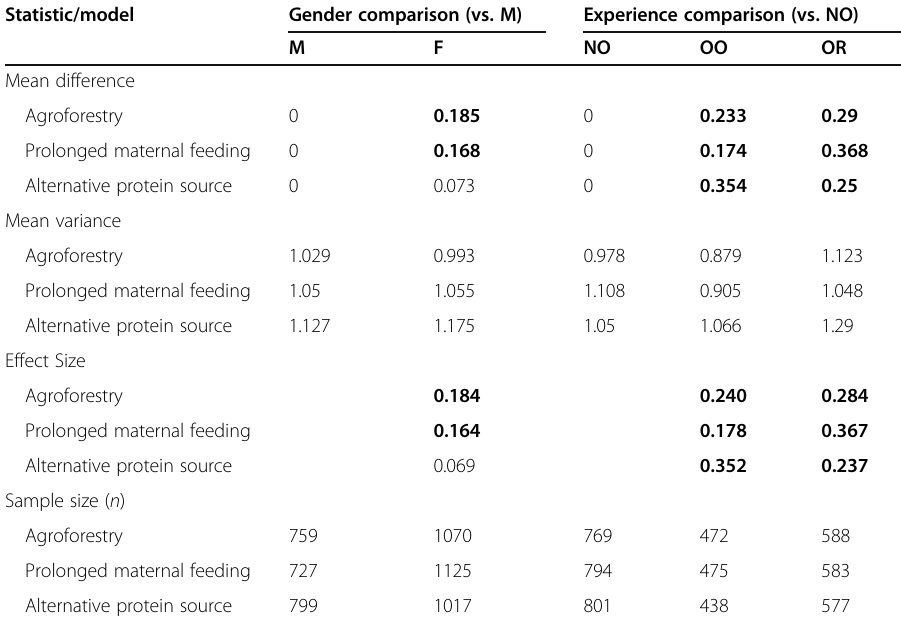
Bold indicates significant differences/effect sizes ( p <